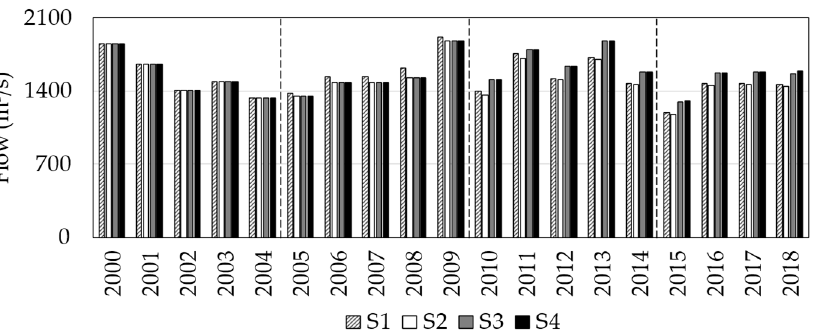
Figure 7. The differences of the total annual flow between the different updated land- use scenar- ios.